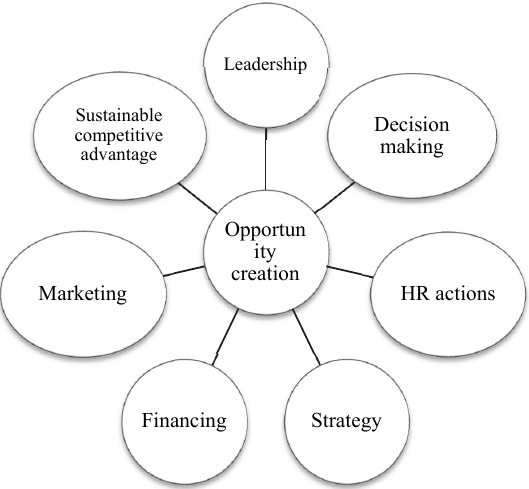
Fig. 2. Model of effective entrepreneurial actions in creation